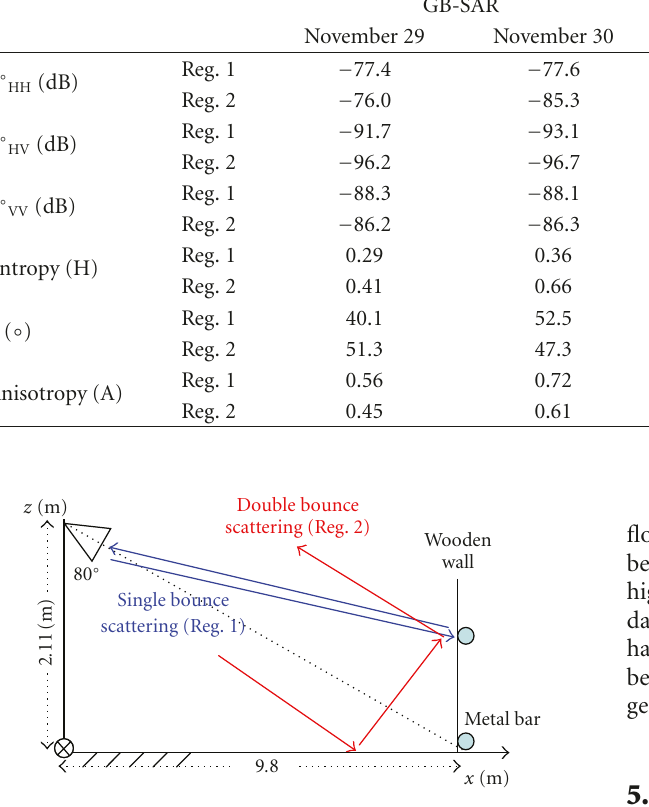
Figure 5: Single and double bounce scattering from the ground surface and metal